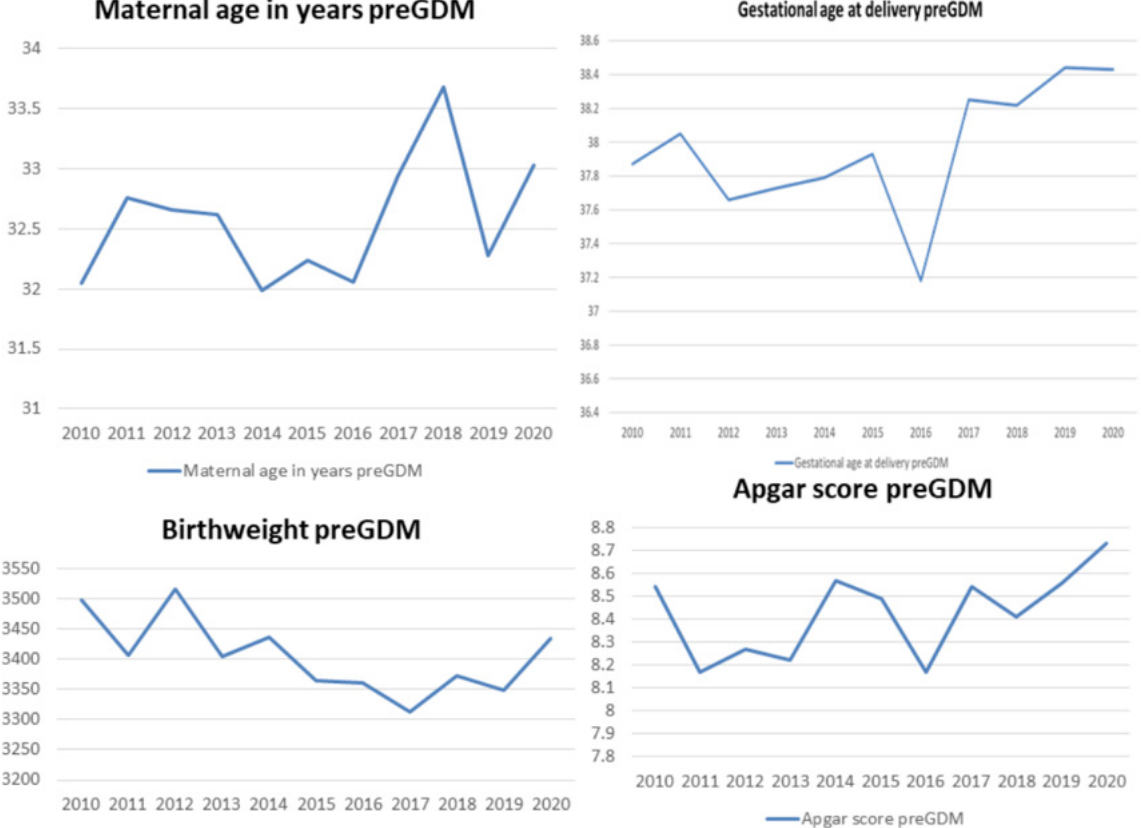
Figure 3. Trends in average maternal age, gestational age at delivery, newborns’ birth weight and average Apgar scores among women with pre-gestational diabetes .